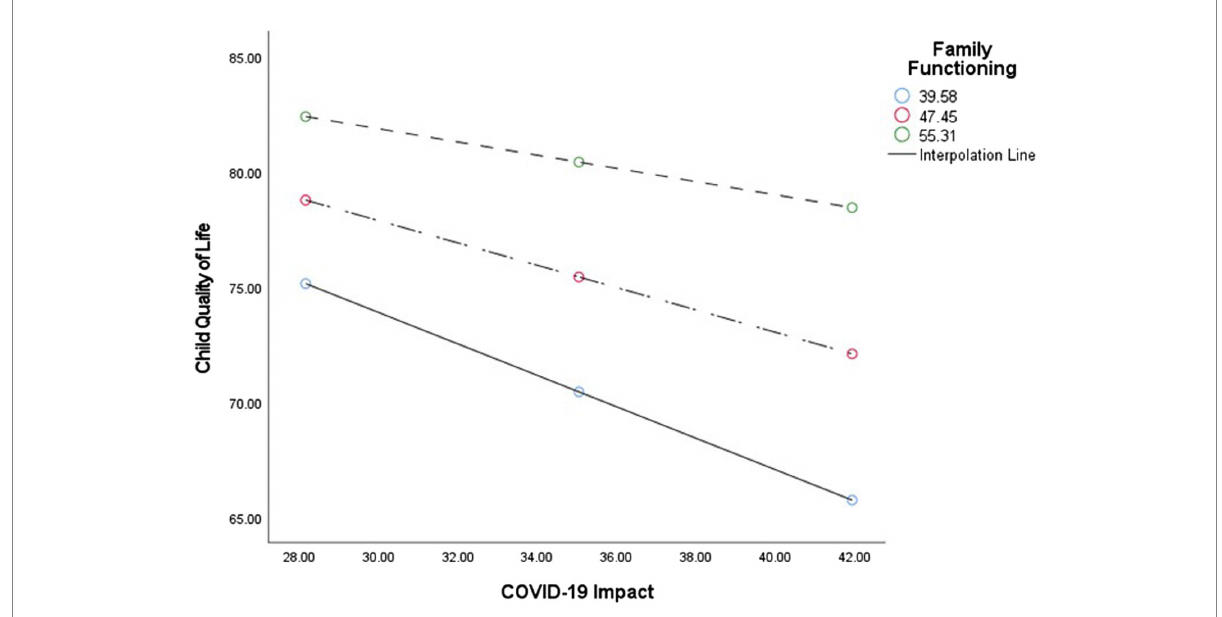
FIGURE 4 Simple slopes. Illustration of the simple-slope analyses for Family functioning with child quality of life and COVID-19 impact scores.